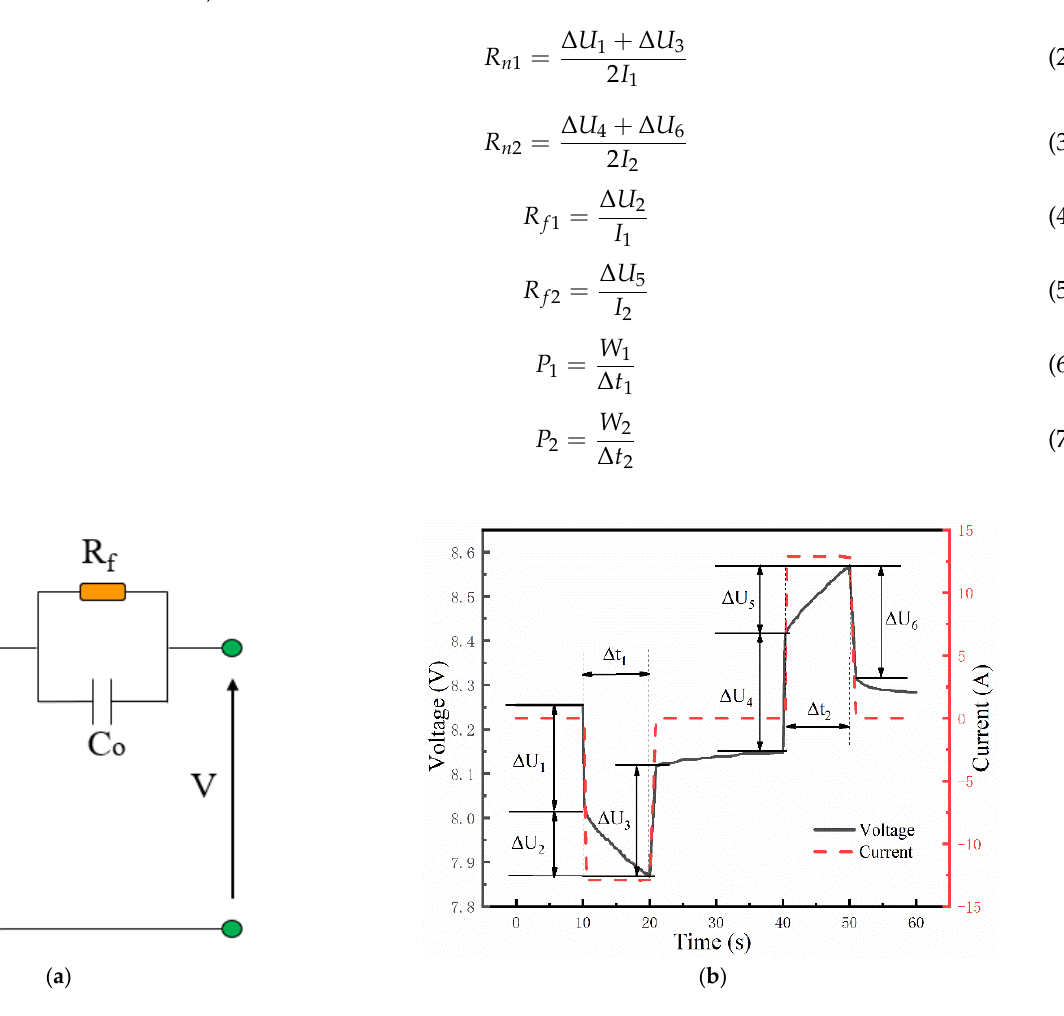
Figure 2. ( a ) Thévenin equivalent circuit model; ( b ) impulse charge and discharge response of Ni- Figure 2. ( a ) Th é venin equivalent circuit model; ( b ) impulse charge and discharge response of MH batteries. Ni-MH